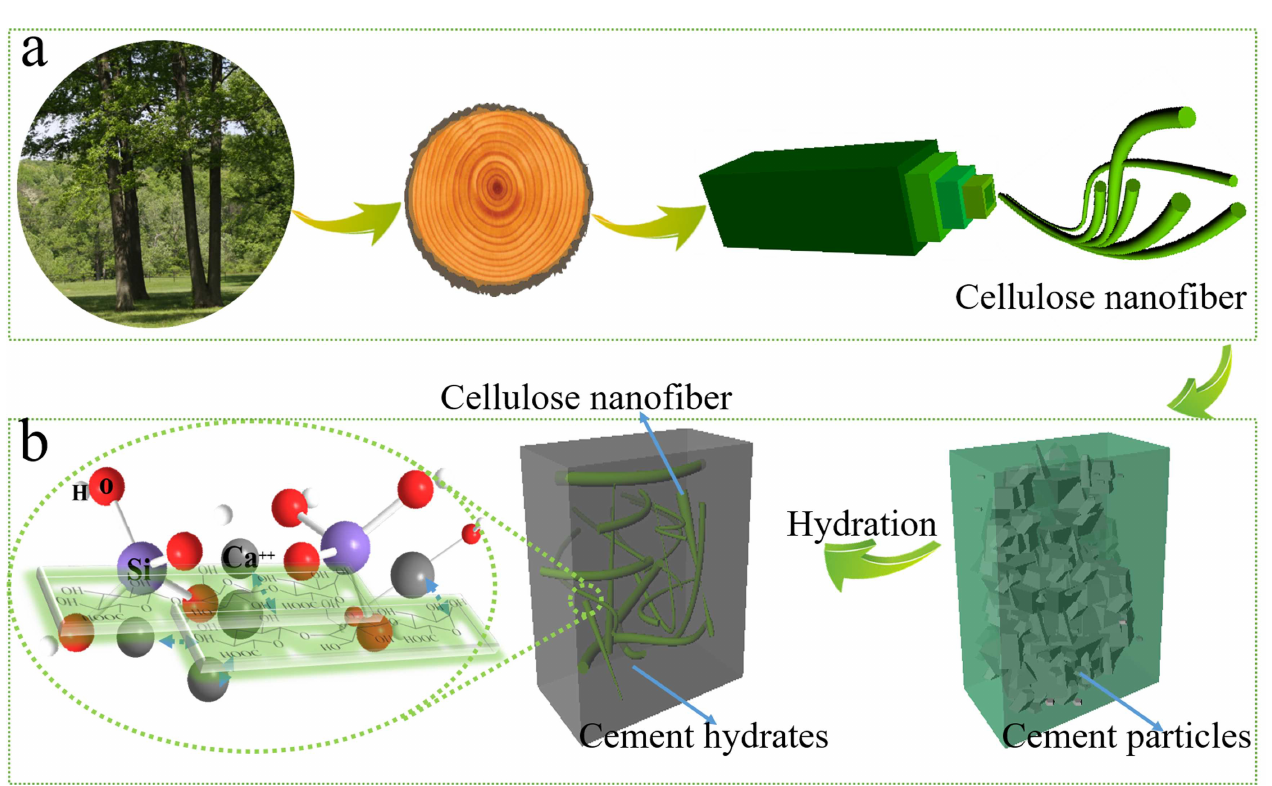
Fig 1. Schematic illustration of the hierarchical structure of a tree and the interaction between cellulose nanofibers and cement particles. (a) The hierarchical structure of celluloses.(b) A network of cellulosenanofibersand cement formed with carboxyl groups and cement